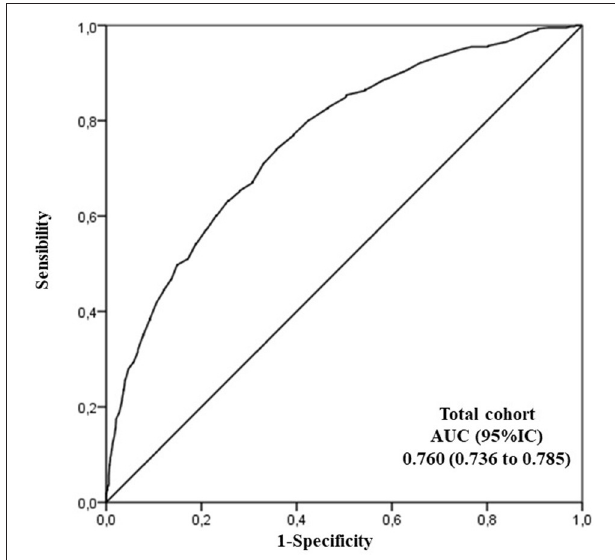
FIGURE 2 | Receiver Operating Characteristics (ROC) curve analysis to evaluate the accuracy of pulse pressure as a measurement of interest to discriminate cerebral microangiopathy patients from non-cerebral microangiopathy together with a sensitivity/specificity report. AUC, area under the ROC curve.